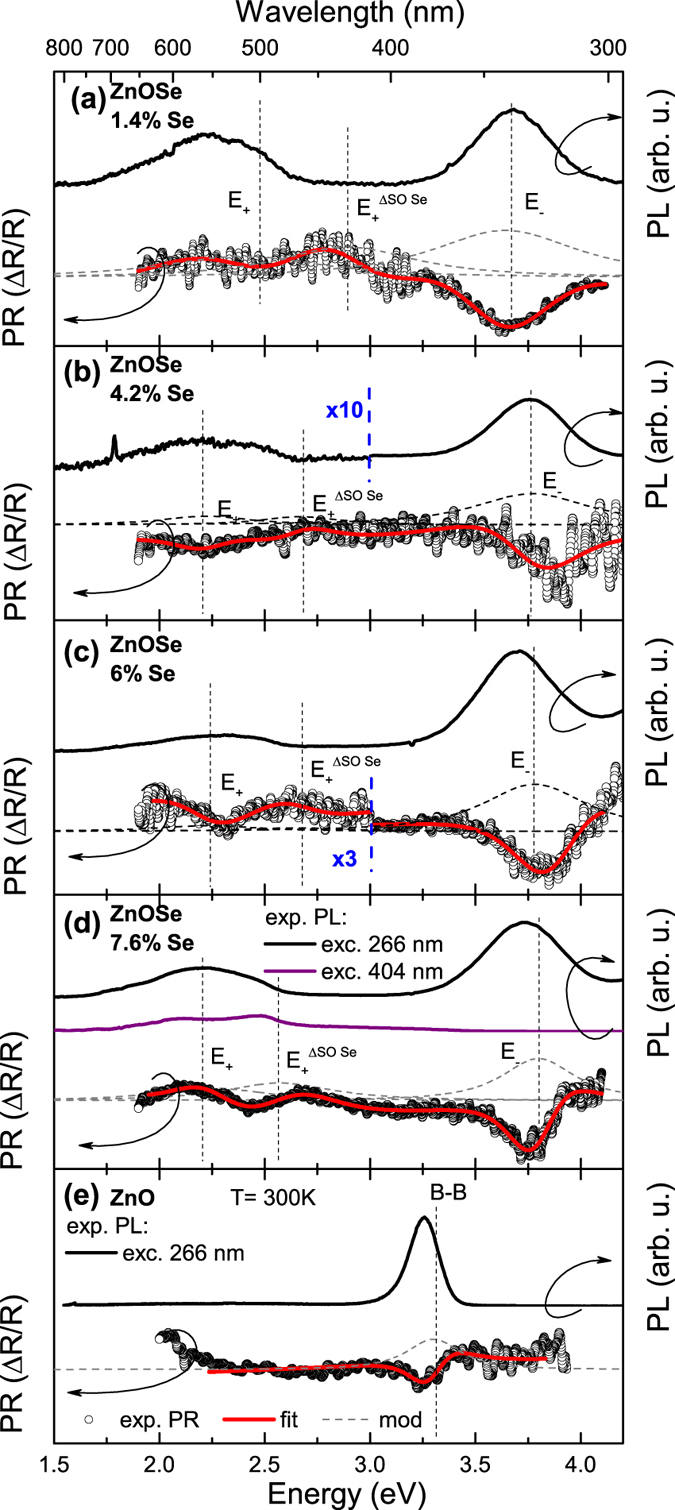
Representative PR and PL spectra of ZnOSe alloys.(a) PL and PR spectra of the ZnO0.986Se0.014 layer. PL was measured under 266 nm (black line) excitation wavelength. The PR spectrum is marked by open circles. The red line is a fitting curve according to Aspnes formula27 with three resonances. The dashed gray lines are moduli of PR resonances with the maxima corresponding to the energies of optical transitions. (b) PL and PR spectra of the ZnO0.958Se0.042 layer. (c) PL and PR spectra of the ZnO0.94Se0.06 layer. (d) PL and PR spectra of the ZnO0.924Se0.076 layer. Additional PL spectrum under 404 nm excitation is also shown (violet line). (e) PL and PR spectra of the ZnO reference film.